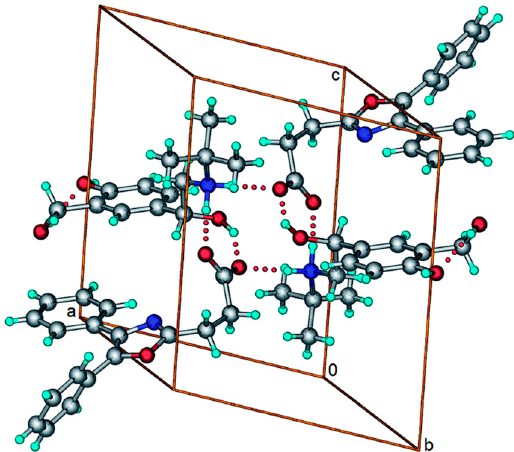
Figure 37. A four-component supramolecular unit in the crystal structure of OXP − -SAL + -H salt. Adapted with permission from RSC Advances , 2016, 6, 34110–34119. Copyright 2016, The Royal Society of Chemistry.